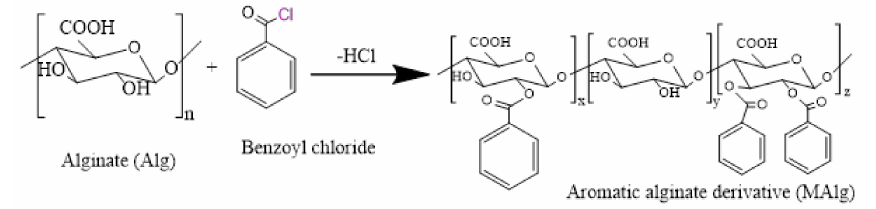
Figure 1. Schematic preparation of aromatic alginate